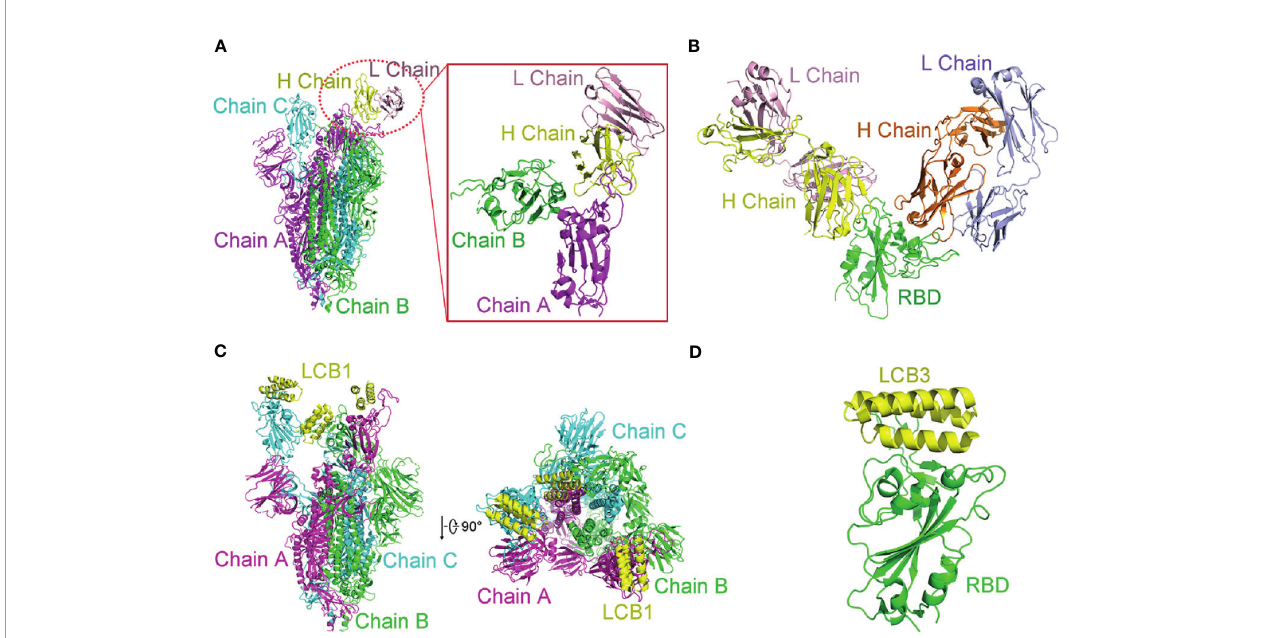
FIGURE 8 | Complex structures of SARS-CoV-2 with antibodies. (A) Cryo-EM structure of BD-23 Fab in complex with the spike (S) trimer. The three protomers in the S trimer are shown in green, cyan, and magenta, respectively. BD23-Fab is colored in yellow (heavy chain) and pink (light chain). The fi gure in the box is an ampli fi ed part of the interaction between BD-23 Fab and Chain (B) (B) Structure of REGN10933 and REGN10987 in complex with RBD. The heavy chain of REGN10933 is orange and light chain of REGN10933 is blue. The heavy chain of REGN10987 is yellow and light chain of REGN10987 is pink. RBD is shown in green. (C) Cryo-EM structure of LCB1 in complex with the S trimer from side view and top view. The three protomers in the S trimer are shown in green, cyan, and magenta, respectively. LCB1 is colored in yellow. (D) Cryo-EM structure of LCB3 in complex with the RBD. The LCB3 is shown in yellow, and RBD is colored in green. All structures are drawn by